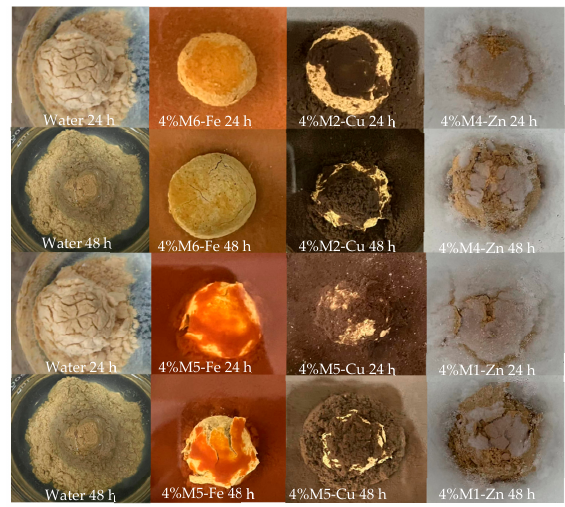
Figure 7 . Experimental results for the mud balls. Figure 7. Experimental results for the mud balls.